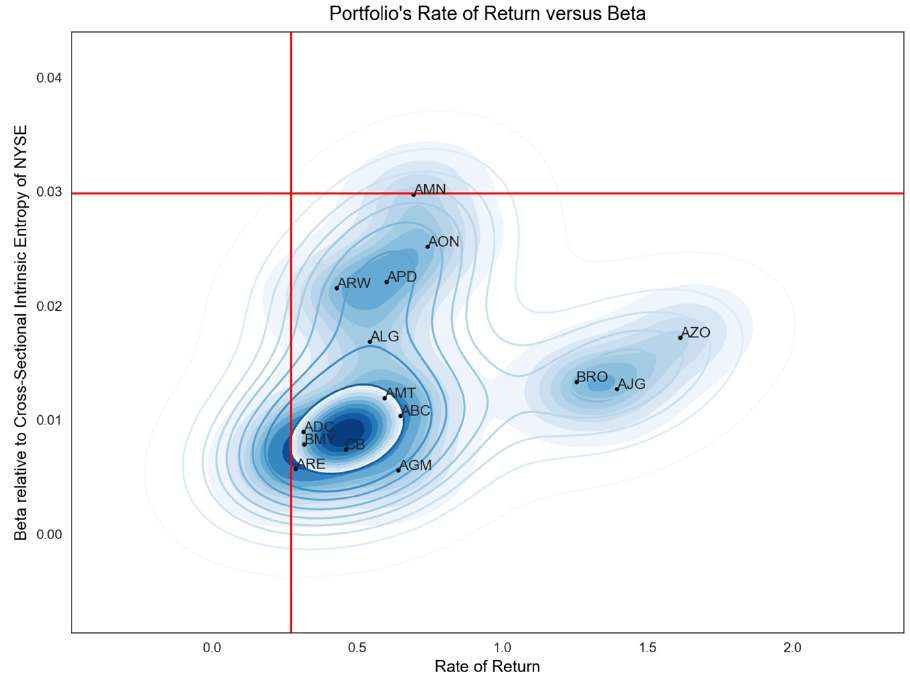
Figure A3. A set of 15 NYSE symbols that outperformed the DJIA index in terms of rate-of-return without being exposed to higher risk (950-day trading interval, from 2 April 2018 to 26 August 2022).